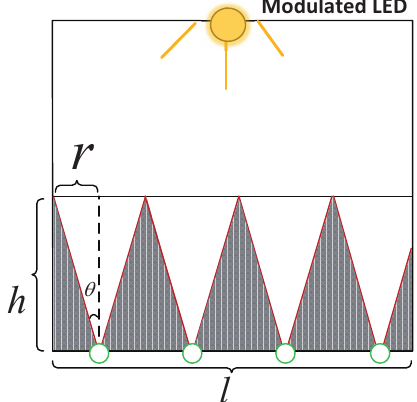
Figure 12. The precise location of the four PDs.